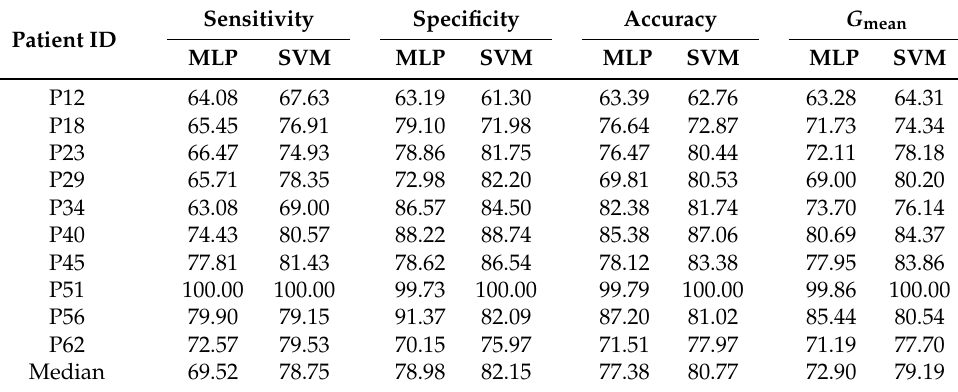
Table 3. Averaged sensitivity ( SN ), specificity ( SP ), accuracy, and Gmean for the best feature vector of each patient over the 100 repetitions performed for both multilayer perceptron networks (MLP) and support vector machines (SVM). Results are presented as a